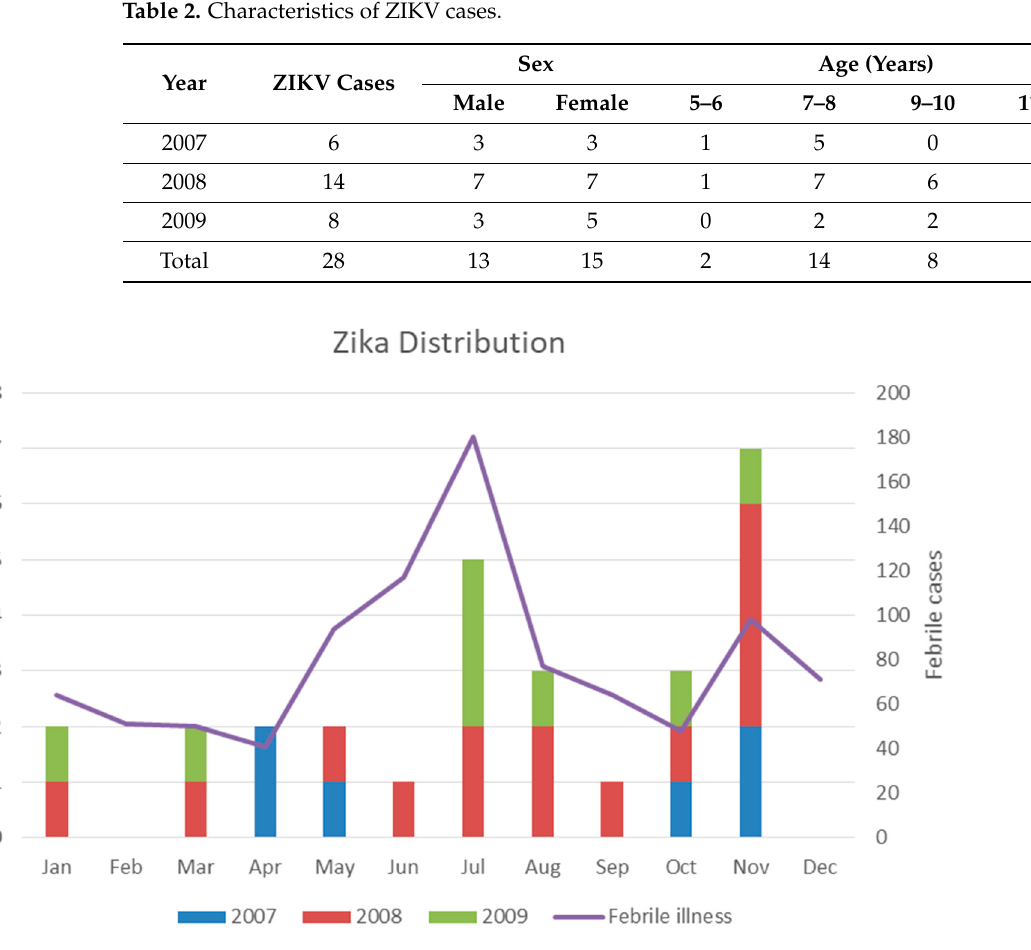
Figure 4. Distribution pattern of symptomatic ZIKV cases from school-aged children in Ratchaburi province, Thailand, from 2007 to 2009. ZIKV cases are shown in 2007 (blue), ZIKV cases in 2008 (red), and ZIKV cases in 2009 (green). The 955 febrile illness cases are shown as the purple line.